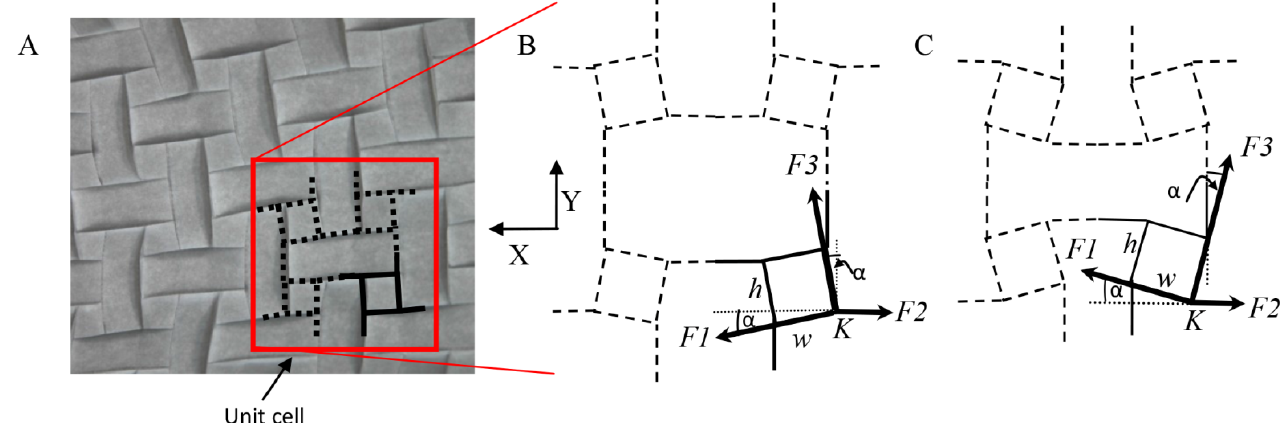
Figure 11. An auxetic origami structure: ( A ) A folded origami tessellation model. Rotation of the unit cell (marked by black lines) causes the pattern to simultaneously contract/extract. ( B ) Unfolded and ( C ) folded states of a unit cell of a tessellation structure ( F1 , F2 , and F3 are the forces at the vertex K ).